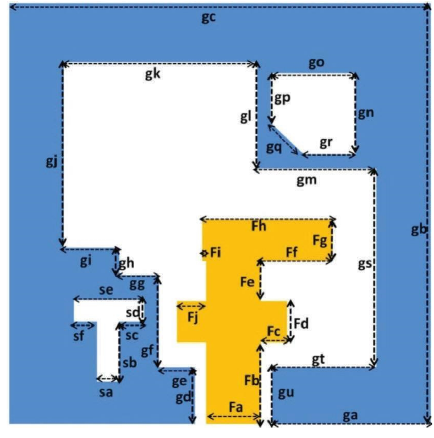
Figure 1: Antenna geometry. Table 1: Design parameters of the proposed